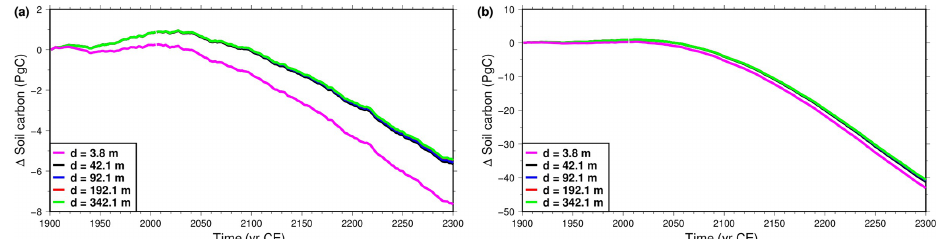
Figure 12. Evolution of soil carbon pool in the Northern Hemisphere permafrost region, compared to the size for the original model at 1901CE. Models with varying bottom boundary depth. (a) Simulations forced with CRUNCEP+RCP4.5 data. (b) Simulations forced with CRUNCEP + RCP8.5 data. Note the vertical scale difference between the two panels.